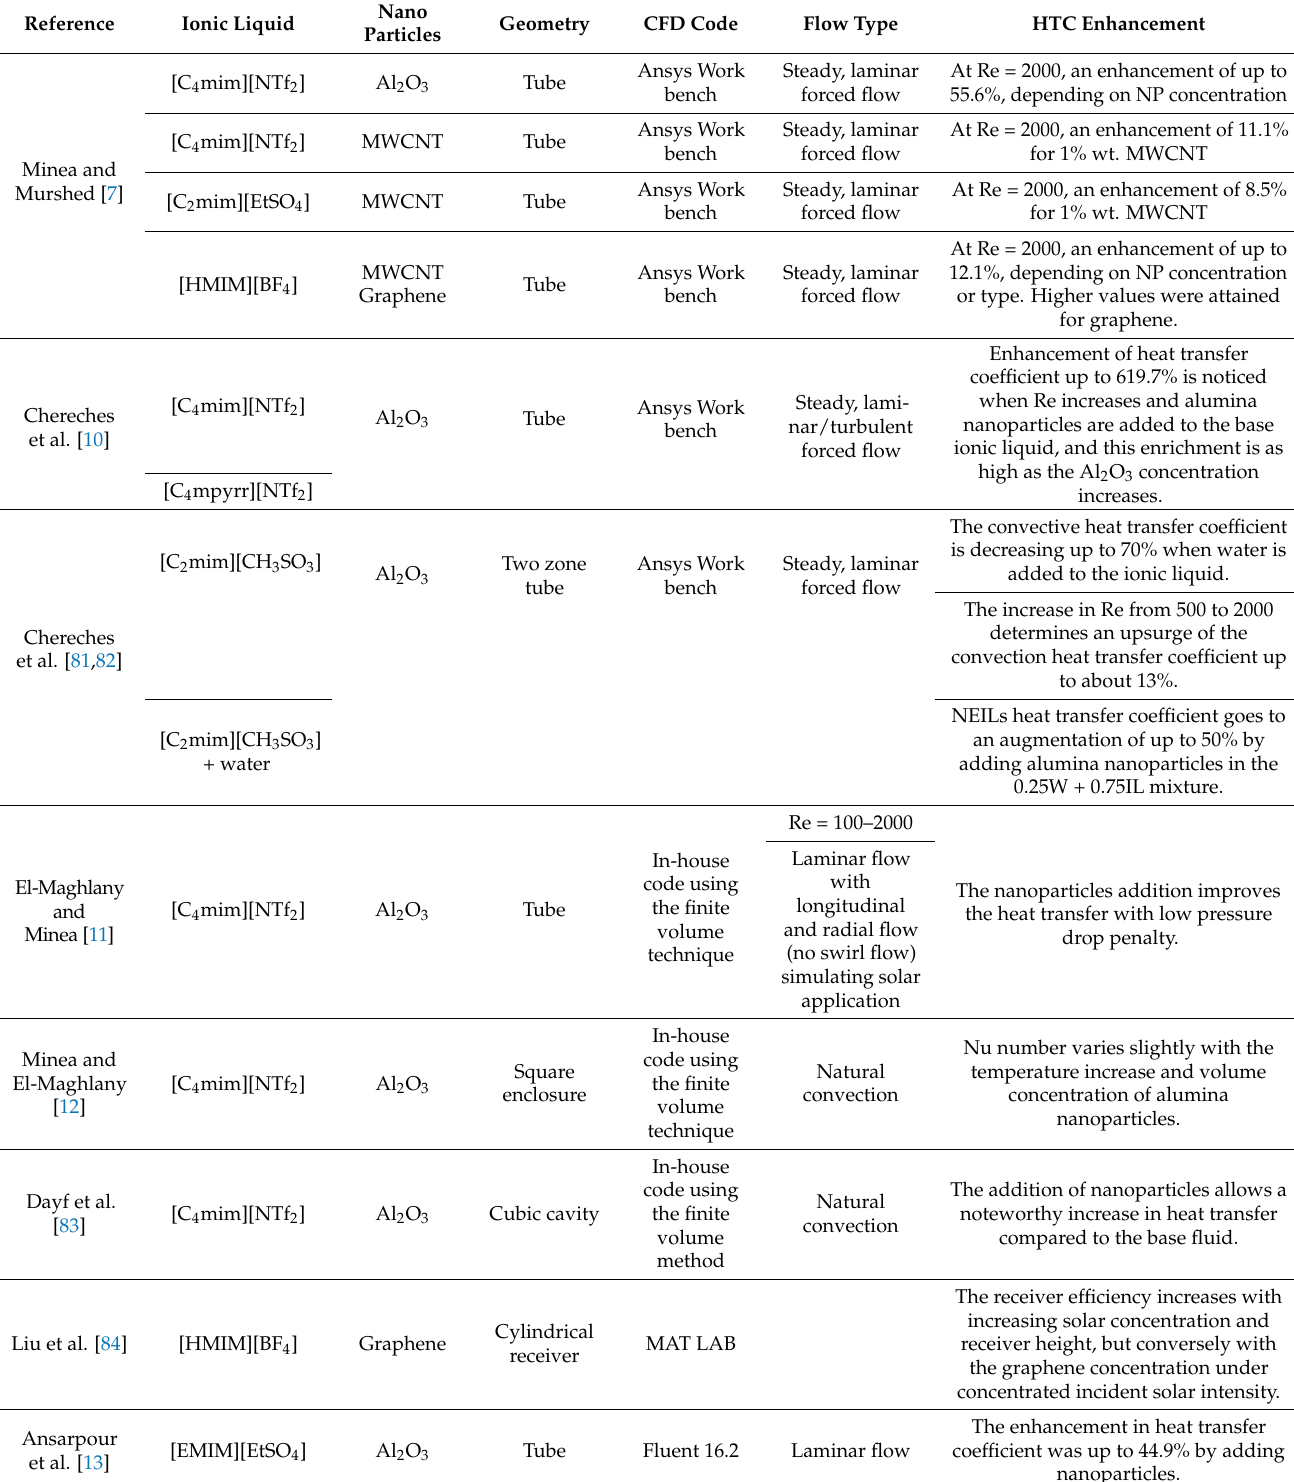
Table 8. Results on numerical implementation of ionic liquids-based